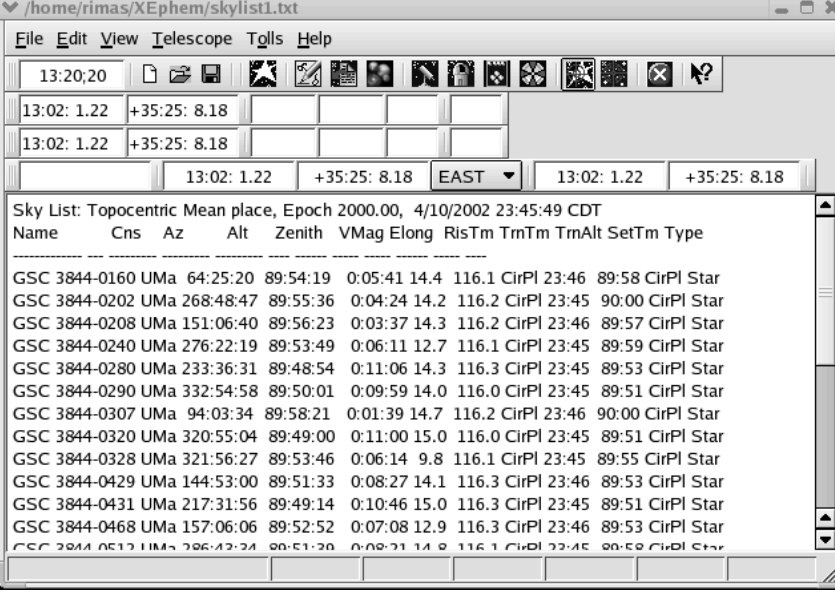
Fig. 1. The screenshot of the LYRA